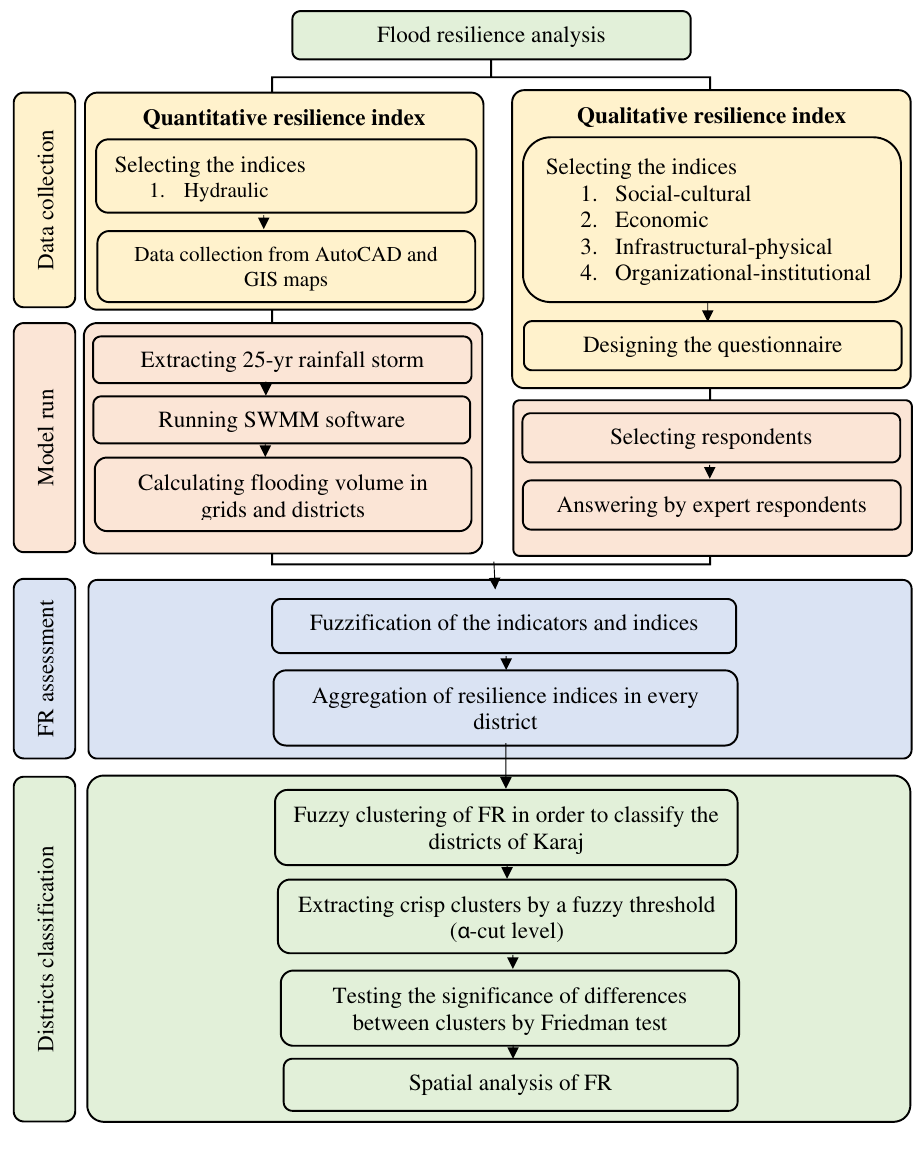
Figure 1. Summary of the methodology used in this study.